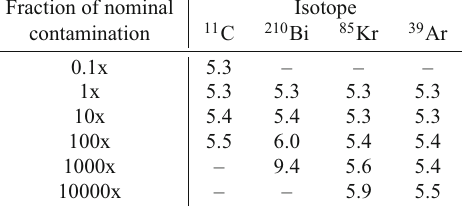
Table 10 Fit uncertainty for 5 years of data with the baseline detector configuration versus alpha and BiPo in-window and out of window rejection